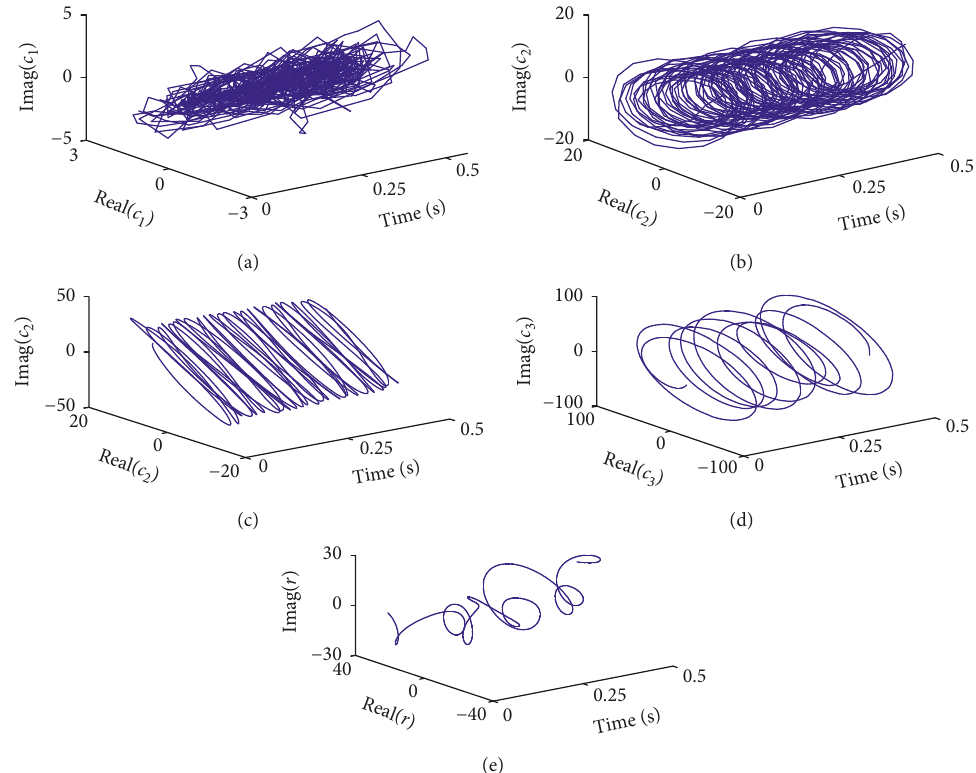
Figure 20: The decomposition results of the composite fault signal based on the improved BEMD